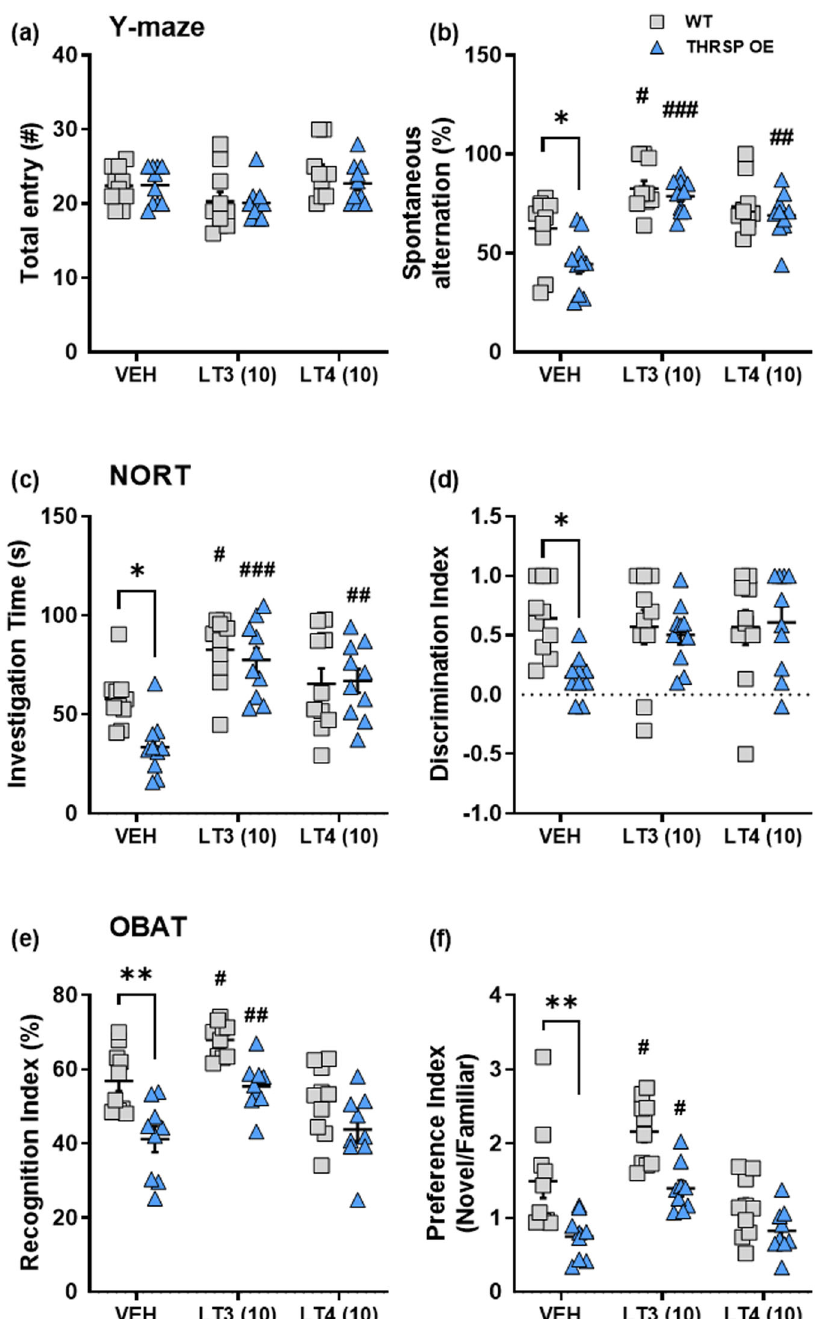
Fig. 6 Effects of TH replacement on inattention in THRSP OE mice. Separate cohorts of mice were treated with LT3 and LT4 (10 mg kg − 1 ) for seven days. Thirty minutes after the last treatment dose, mice were exposed to the Y-maze test, NORT, and OBAT. The a total arm entry, b spontaneous alternations, c investigation time, d discrimination index, e recognition index, and f preference index were scored. a n = 10 mice/group; two-way ANOVA; F (1,54) = 0.473, P = 0.495; b F = 6.89, P = 0.011; c F = 3.94, P = 0.052; d F = 3.40, P = 0.071; e n = 9 – 10 mice/group; two-way ANOVA; F (1,54) (1,54) (1,54) P < 0.001; f F = 26.5, P < 0.001)). TH replacement improved inattention in THRSP OE mice. Values are presented as the mean ± S.E.M. * P < 0.05 and (1,51) ** P < 0.01 (relative to WT), and # P < 0.05, ## P < 0.01, ## P < 0.001 (relative to VEH treatment) by two-way ANOVA with Bonferroni ’ s multiple comparison